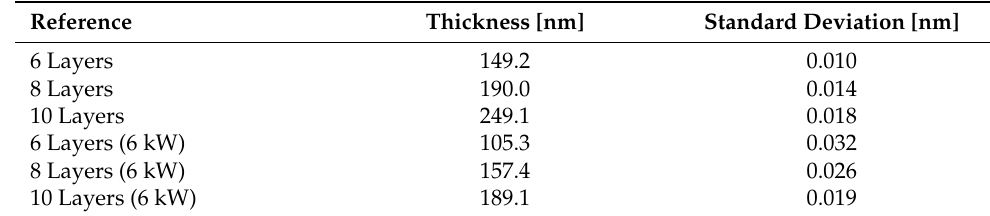
Table 3. Thicknesses of the thin coatings obtained through scanning electron microscopy (SEM).